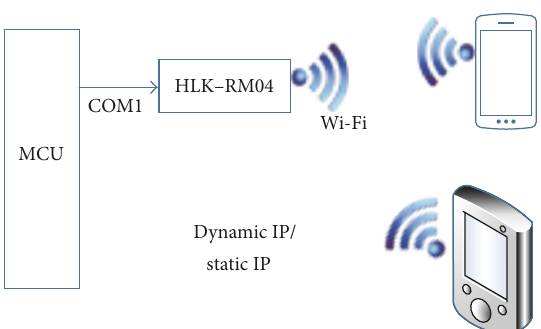
Figure 6: Schematic diagram of communication between the upper monitor and the lower